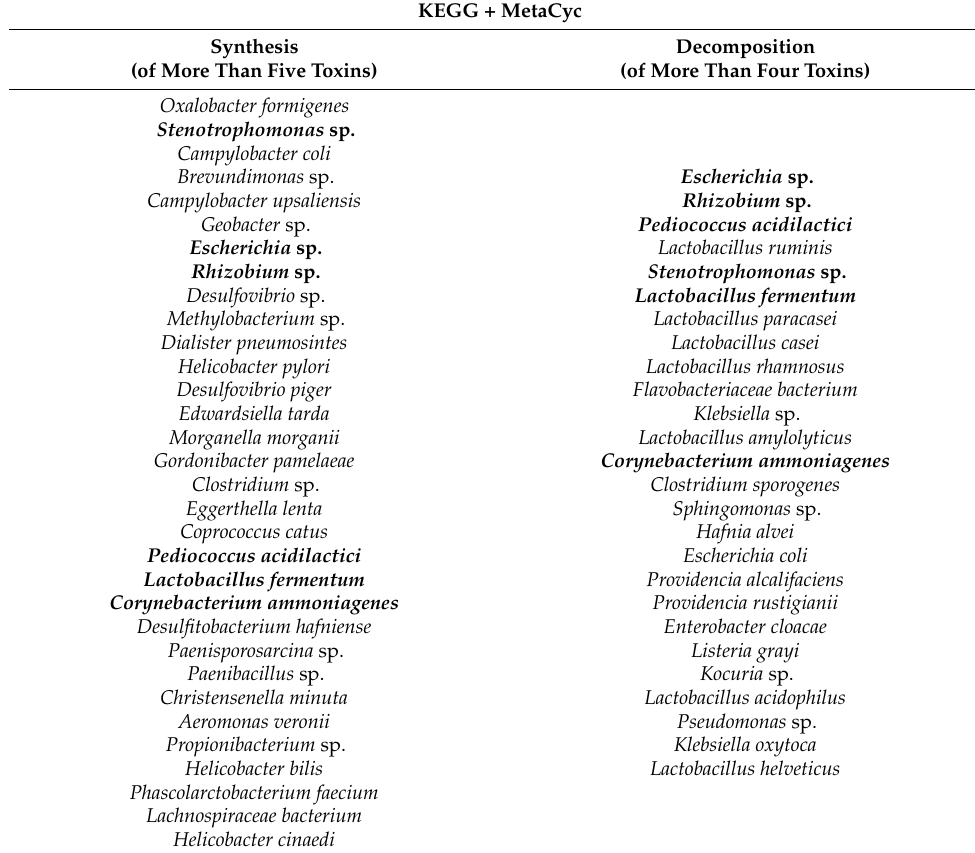
Table 2. Bacteria determined as potential producers or consumers of some uremic retention so- lutes using analysis of KEGG modules with the MetaCyc database. Bacteria presented have more than five toxin-producing reactions (without decomposing the same toxin) or more than four toxin- decomposing reactions (without synthesizing the same toxin). A complete list is available in Supple- mentary Table S3. Bacteria identified as both synthesizing and decomposing are presented in bold.